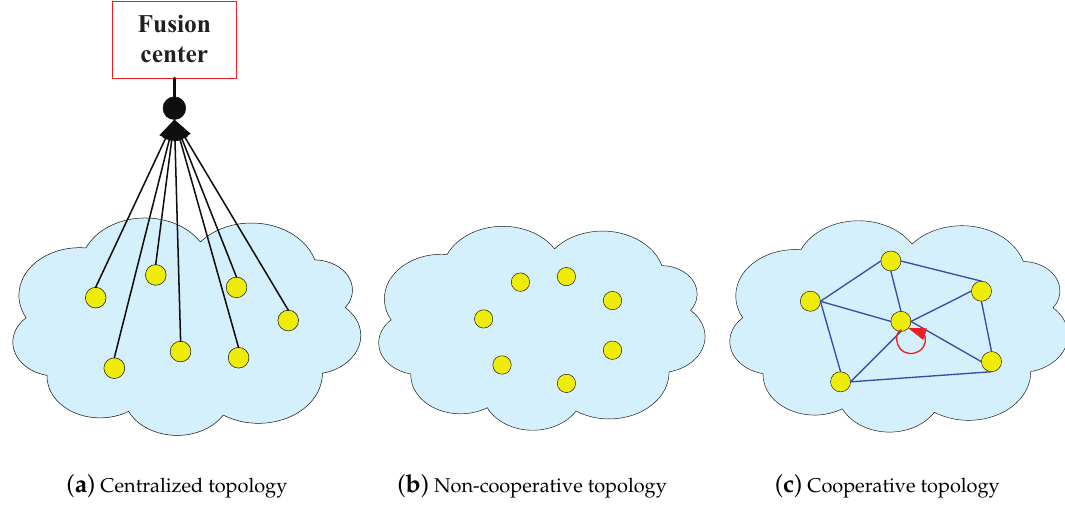
Figure 1. The topology of intelligent wireless sensor network